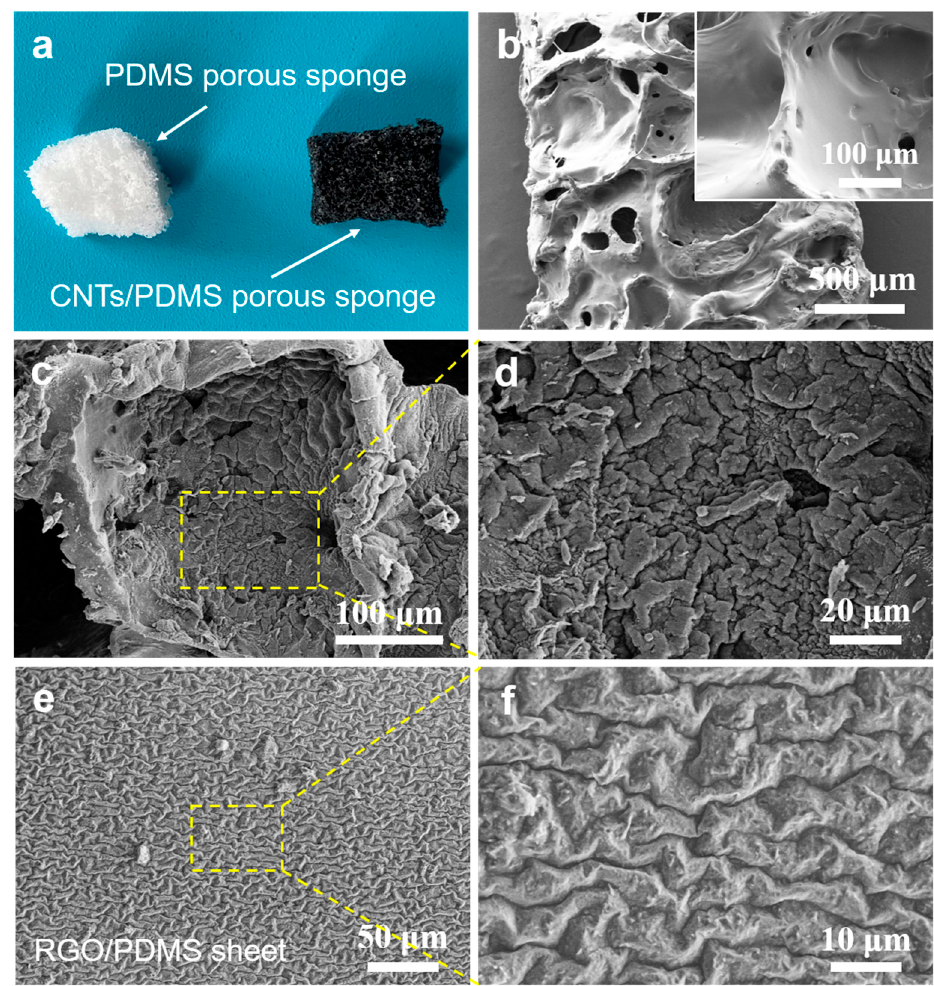
Figure 4. ( a ) Photographs of pristine porous PDMS sponge and CNTs/PDMS porous sponge. ( b ) Surface morphologies of porous PDMS sponge. ( c , d ) Surface morphologies of CNTs/PDMS porous sponge. ( e , f ) Surface morphologies of RGO/PDMS sheet fabricated by ultrasonic-assisted deposition method.